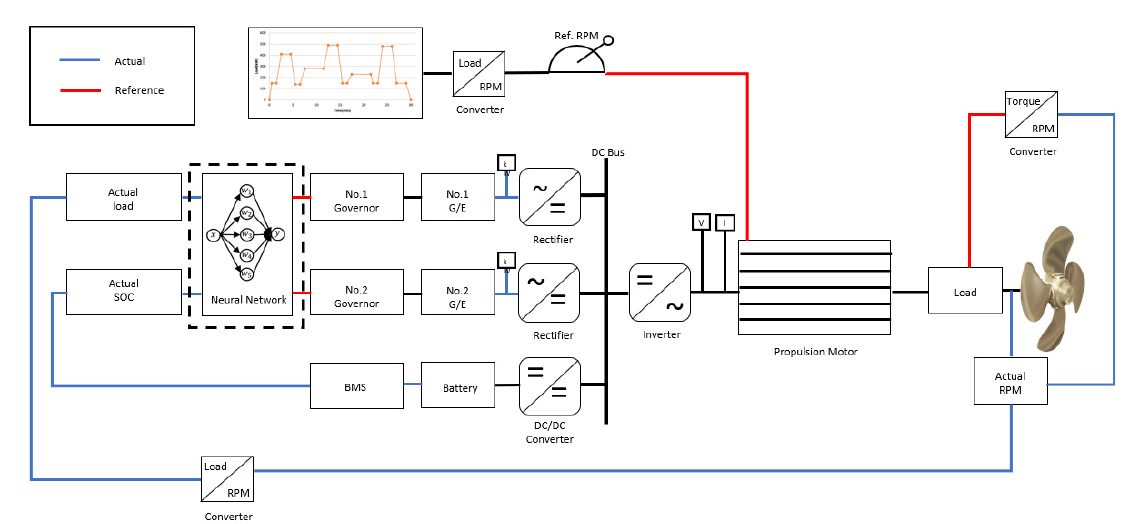
Figure 6. Generator–battery hybrid system using neural network.